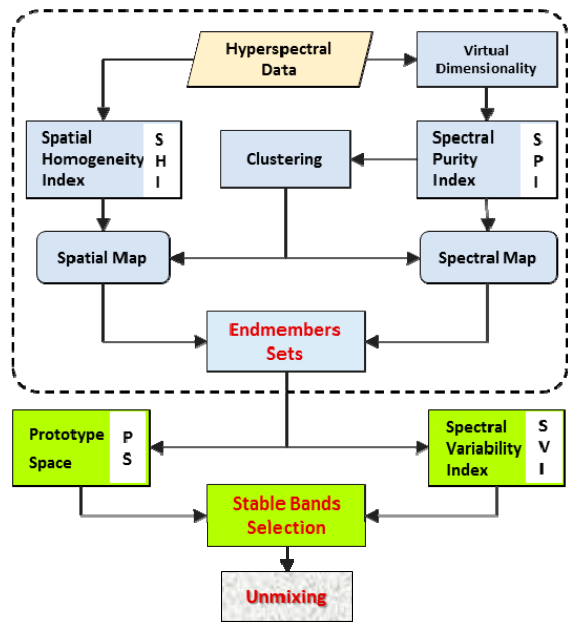
Figure 1. Flowchart of the proposed method.